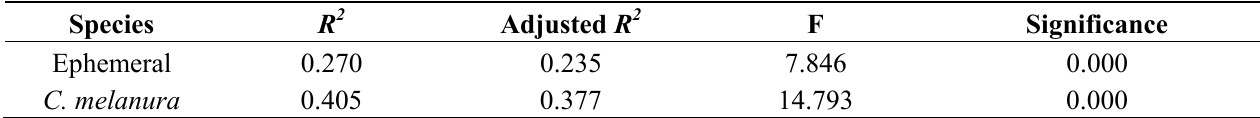
Table 4. Summary results of the EEV linear regression models.